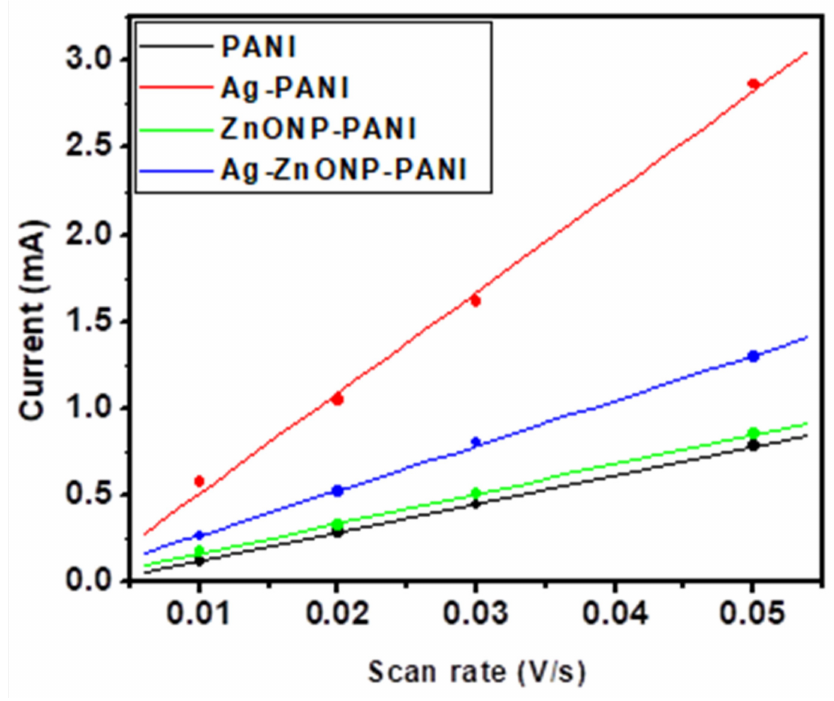
Figure 9. Brown–Anson plots of the anodic peak currents obtained from Figure